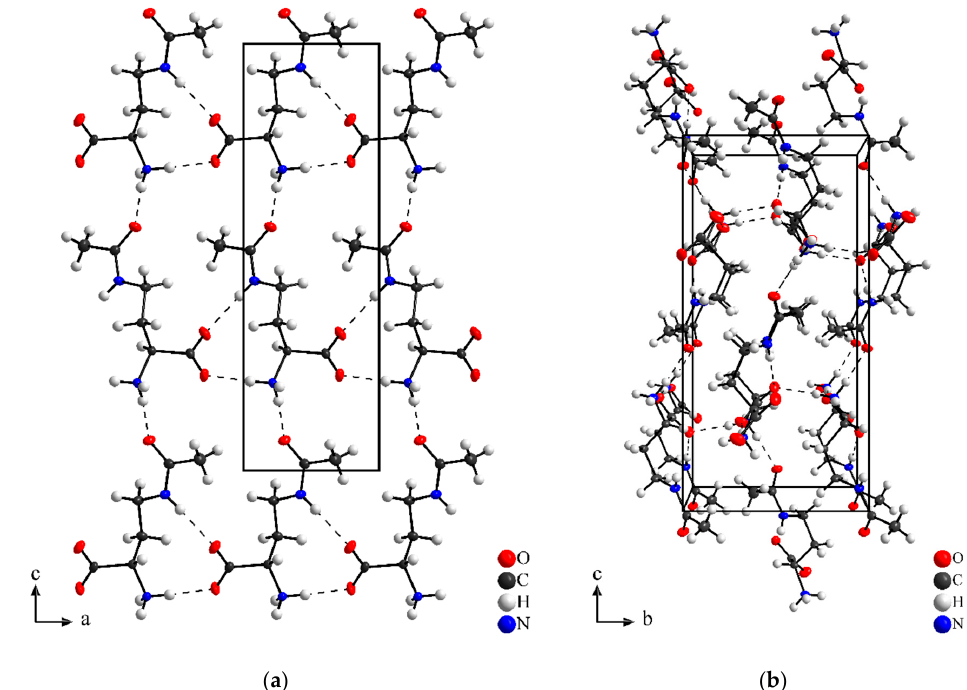
Figure 4. Crystal structure of γ -NADA at 100 K, view along [010] ( a ) and [–100] ( b ). Atoms are shown at the 80% probability level with carbon as black, hydrogen is white, oxygen as red, and nitrogen as blue ellipsoids. Strong H bonds are drawn as dashed lines.